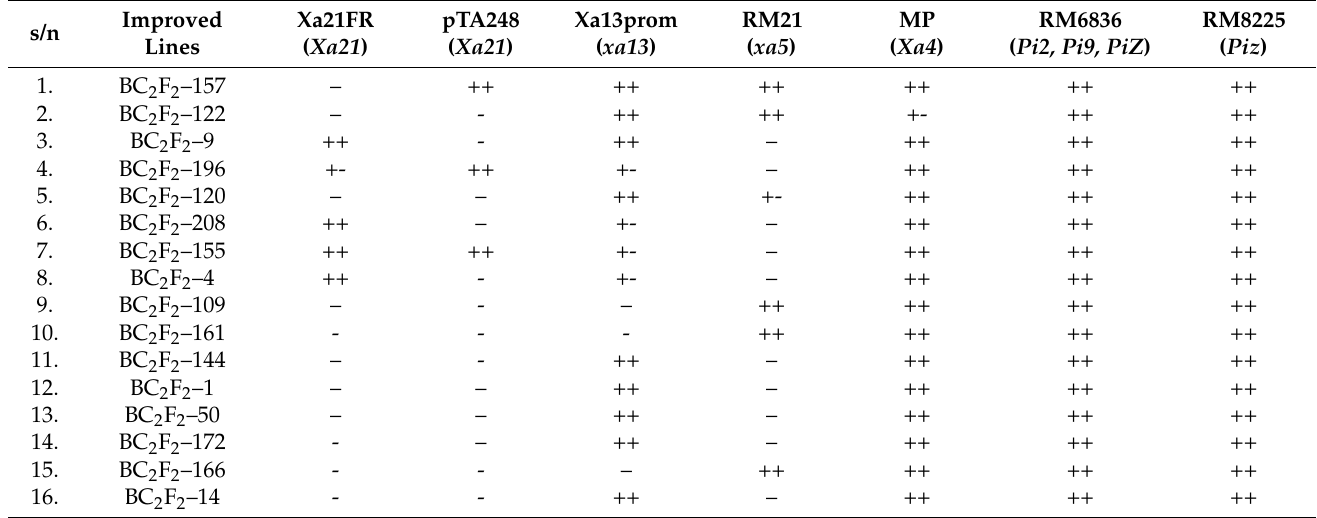
Table 3. Genotypic composition of the selected lines based on the seven pyramided genes of